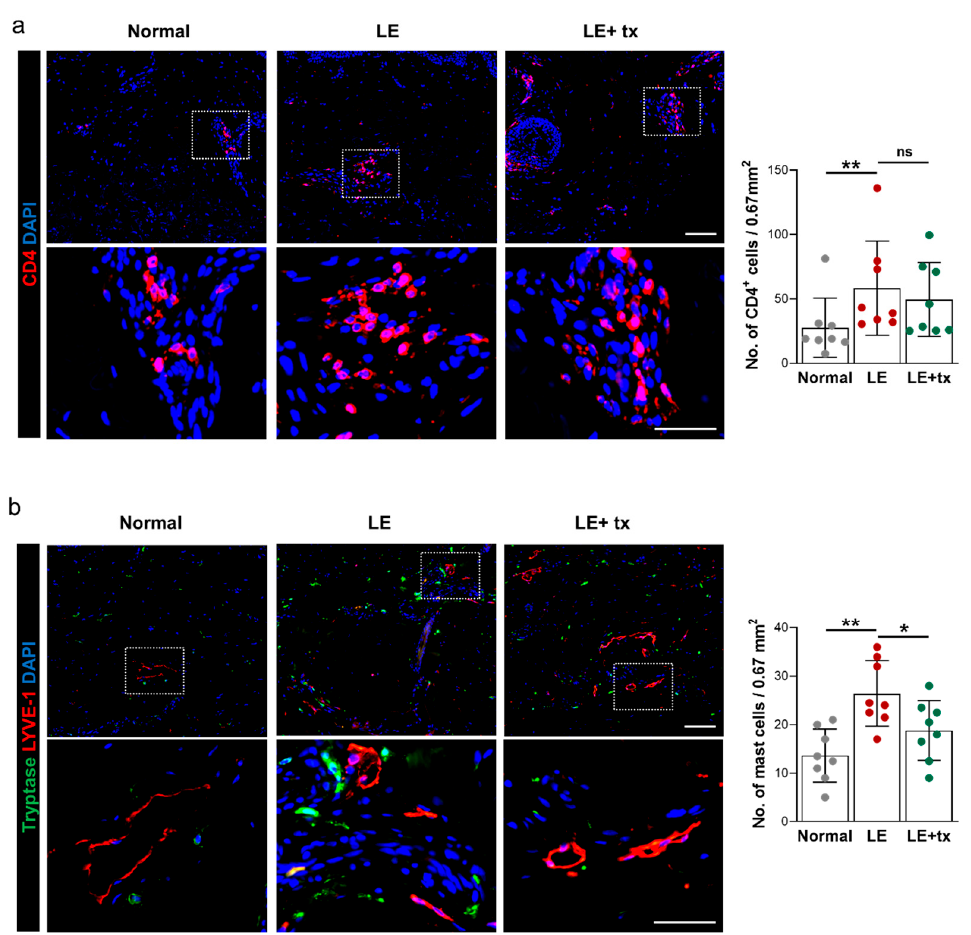
Figure 5. Treatment with QBX258 decreases mast cell infiltration in lymphedematous skin. ( a ) Representative low-power (upper images) and high-power (lower images) immunofluorescent staining (left panels) and quantification (right panel) of DAPI (blue) and CD4 + cells (pink) in normal, LE, and LE + tx biopsy specimens. Area in dotted box is shown in high-power views. ( b ) Representative low-power (upper images) and high-power (lower images) immunofluorescent staining (left panels) and quantification (right panel) of DAPI (blue), LYVE-1 (red), and tryptase (green) in normal, LE, and LE + tx biopsy specimens. Area in dotted box is shown in high-power views. Scale bar (low-power images): 200 µ m; scale bar (magnified images): 25 µ m; * p < 0.05; ** p <